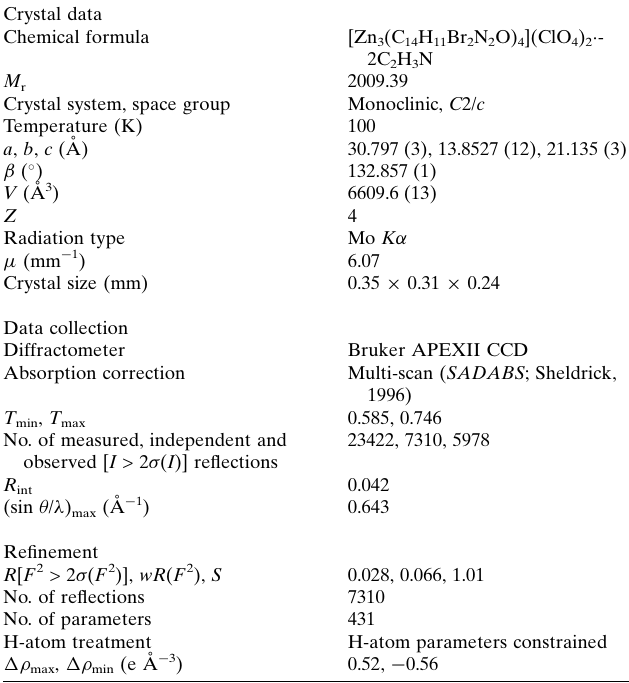
Table 2 Experimental details. Crystal data Chemical